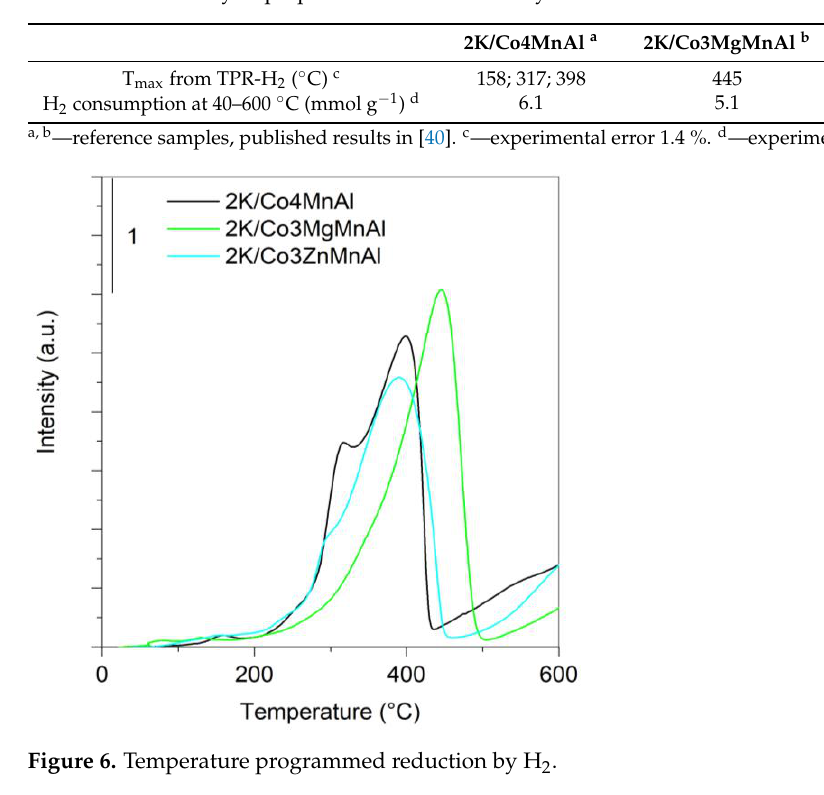
Table 5. Reducibility of prepared mixed oxide catalysts.